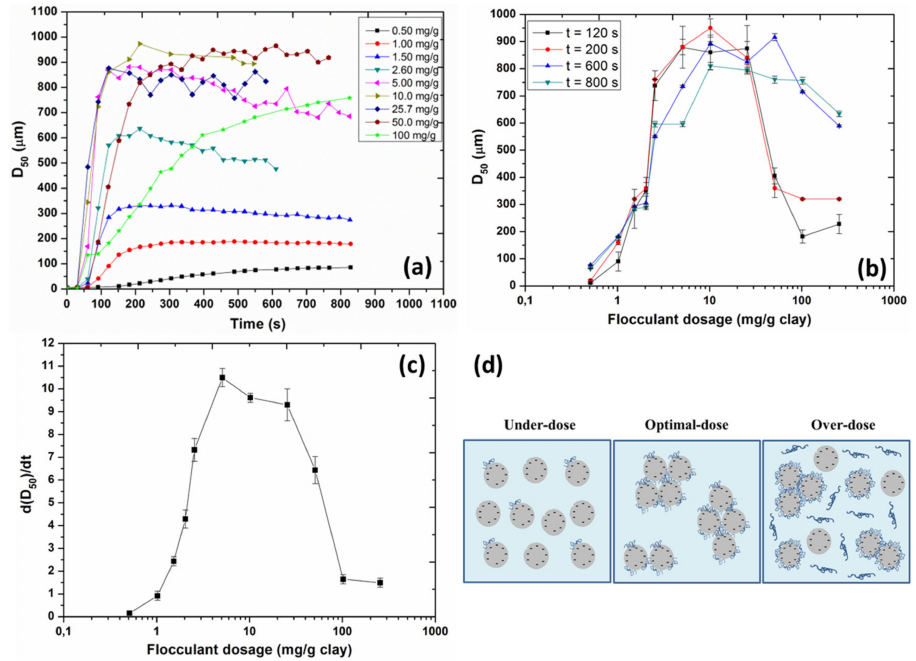
Figure 6. ( a ) Evolution of D 50 as a function of time for clay concentration of 0.7 g / L with di ff erent concentrations of cationic flocculant, ( b ) evolution of D 50 as a function of flocculant to clay ratio (mg / g), ( c ) dD 50 / dt as a function of flocculant to clay ratio (mg / g) and ( d ) schematic representation of flocculation of clay at under-dose, optimal-dose and over-dose of flocculant. Grey circles represent the clay particles and blue lines represent the flocculant. Bars represent standard